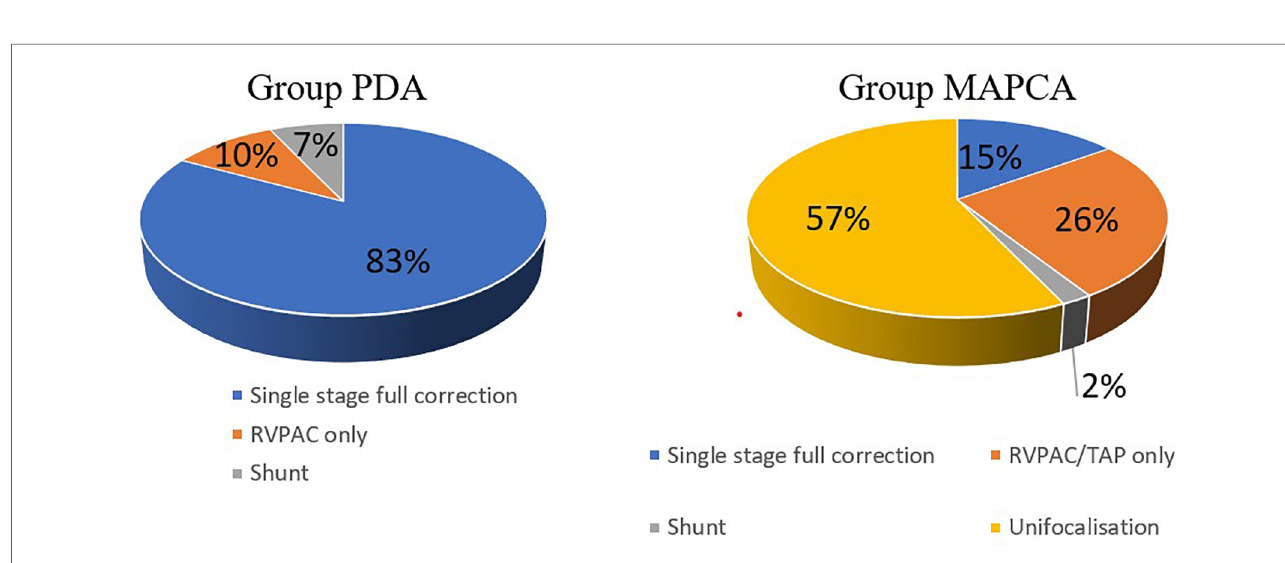
FIGURE 1 Primary surgical procedures (subgroup